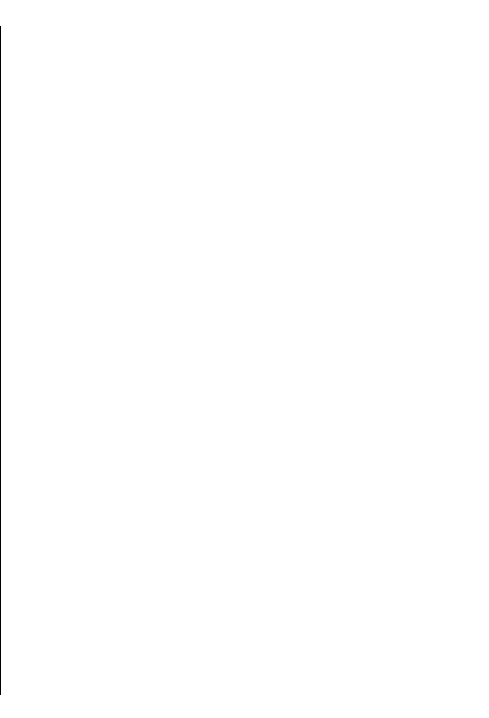
Table 4. Output from the pairwise comparison testing for differences in annual average biomass (CPUE) and density (nCPUE) values between inside and outside of the three FPAs, across